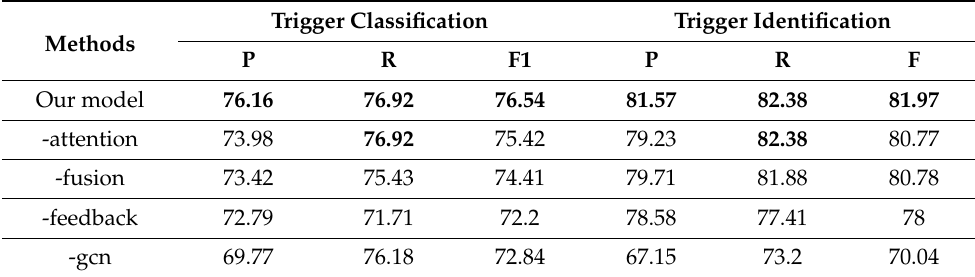
Table 4. Ablation results of our